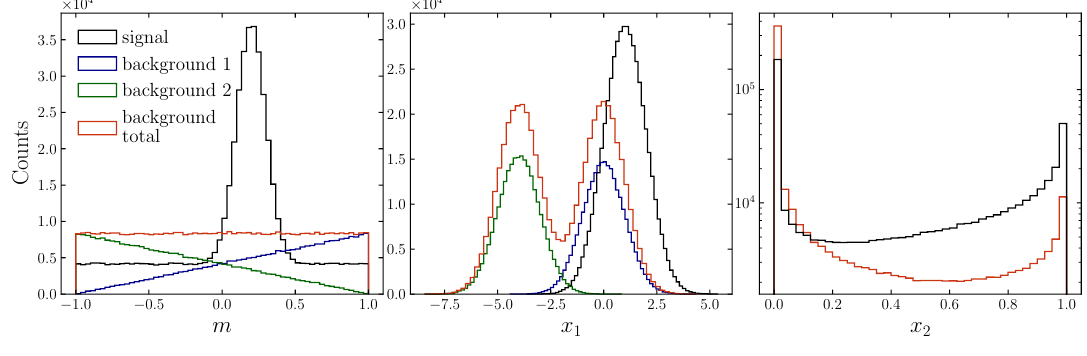
Figure 1 . Simple model distributions.